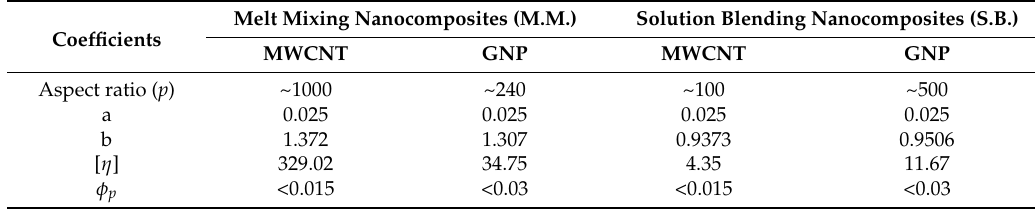
Table 2. Coefficients of Equation (3) and the rheological percolation